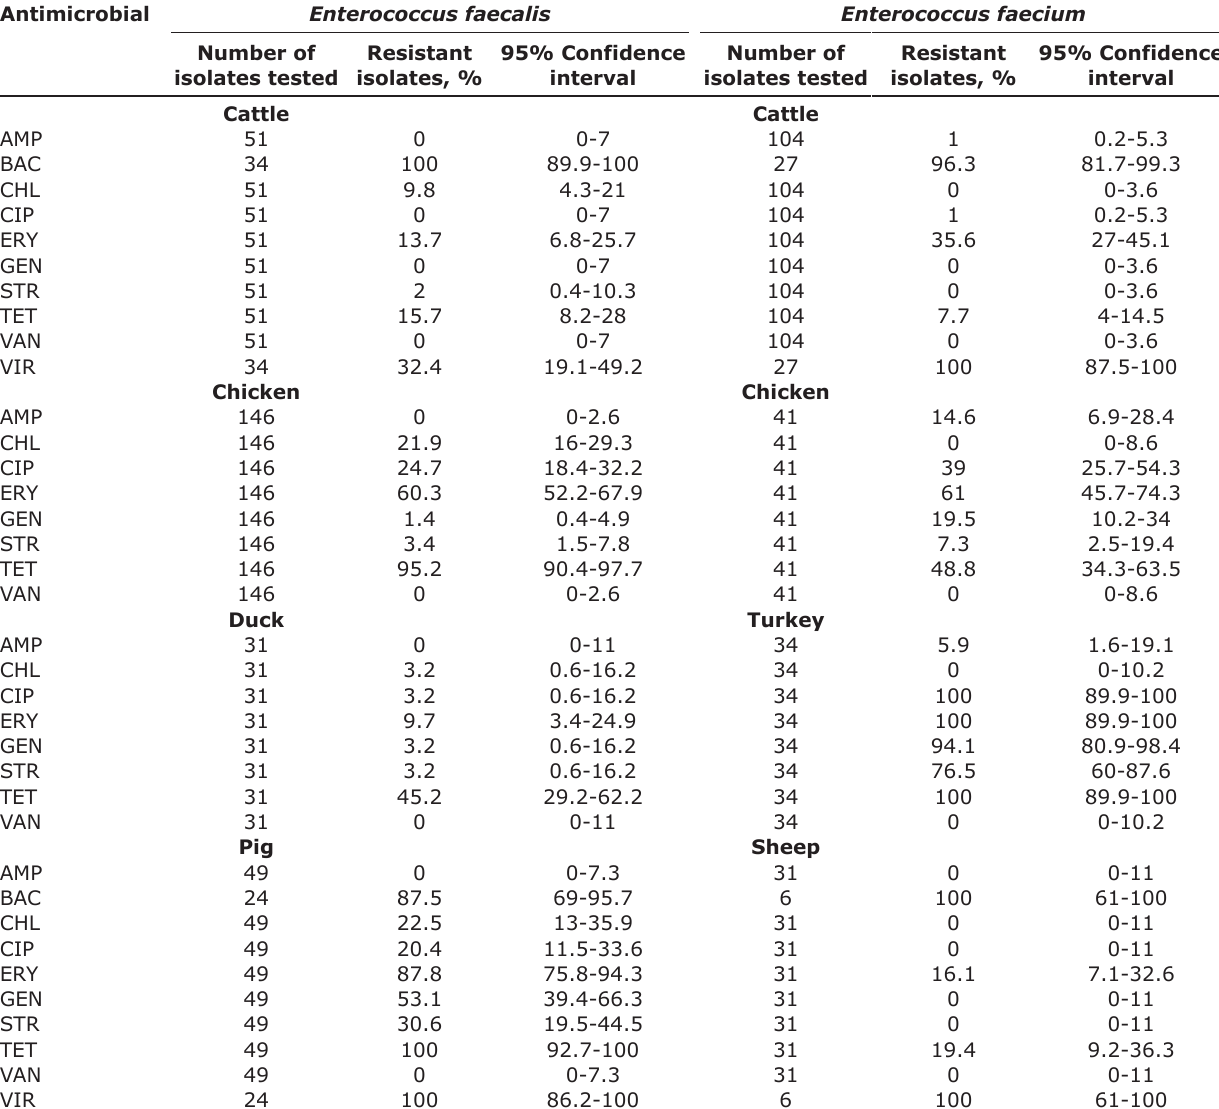
Table-2: Resistance patterns of enterococci isolates, depending on the animal species (interpretation against ECOFFs).